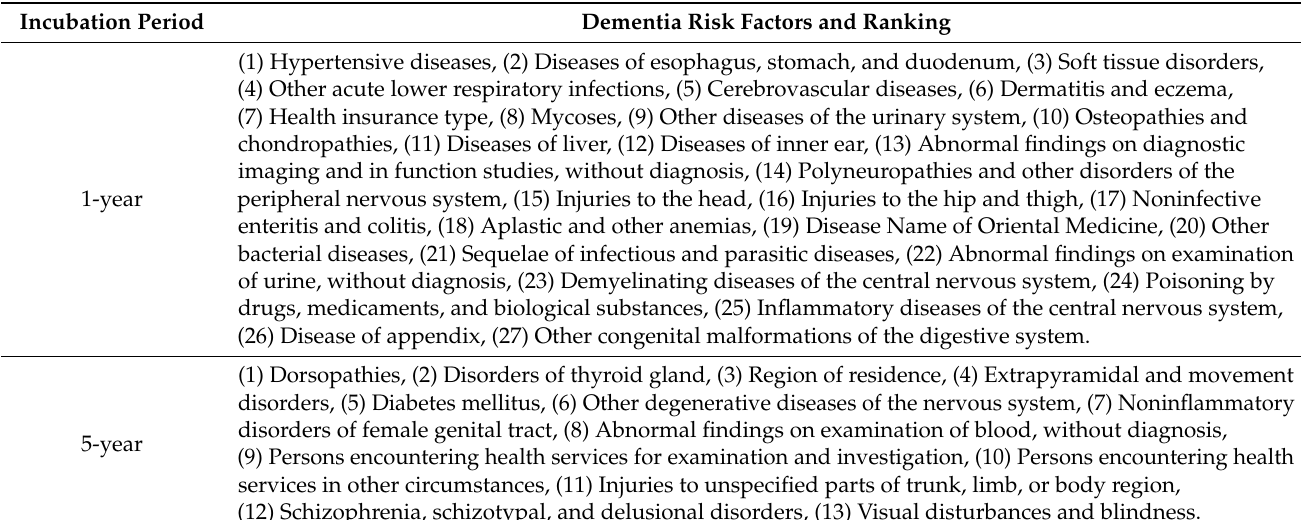
Table 8. Dementia risk factors showing differences between the 1- and 5-year incubation period models.